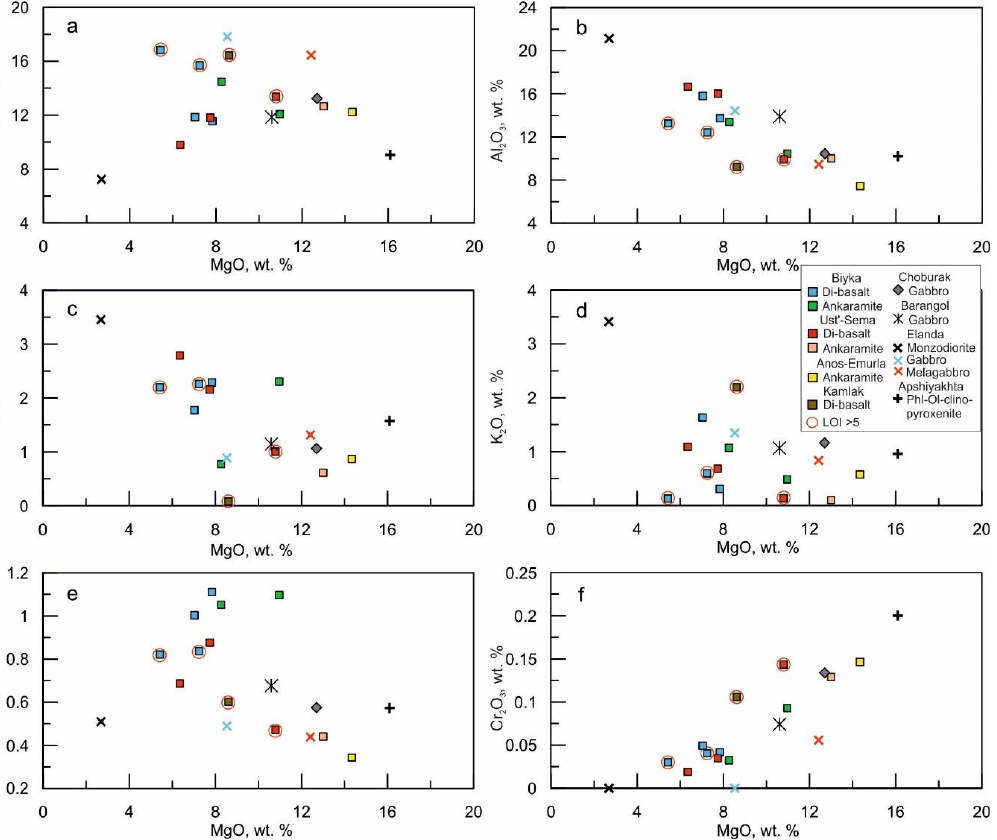
Figure 5. Variations in the MgO content (wt.%) with respect to the contents of other major compo- ( b ) MgO vs. Al 2 O 3 ; ( c ) MgO vs. Na 2 O; ( d ) MgO vs. K 2 O; ( e ) MgO vs. TiO 2 ; ( f ) MgO vs. Cr 2 O 3